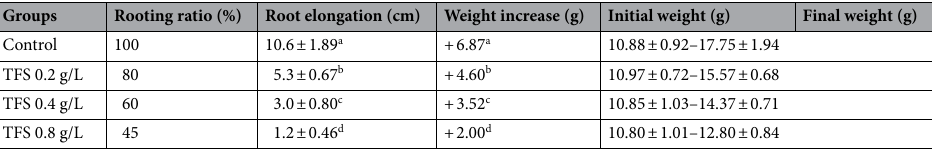
Table 1. Effect of Trifloxystrobin on selected physiological parameters. The averages shown with different letters (a–d) in the same column are significantly different at p < 0.05.